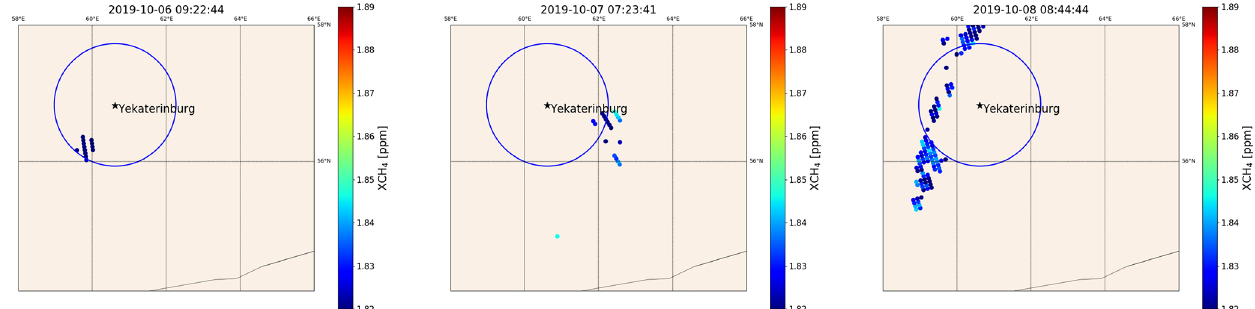
Figure A5. Sample days for TROPOMI measurements (qa = 1 . 0) in October 2019. The circle has a radius of 100km, centred at Yekaterin- burg. The colour represents the value of XCH 4 .